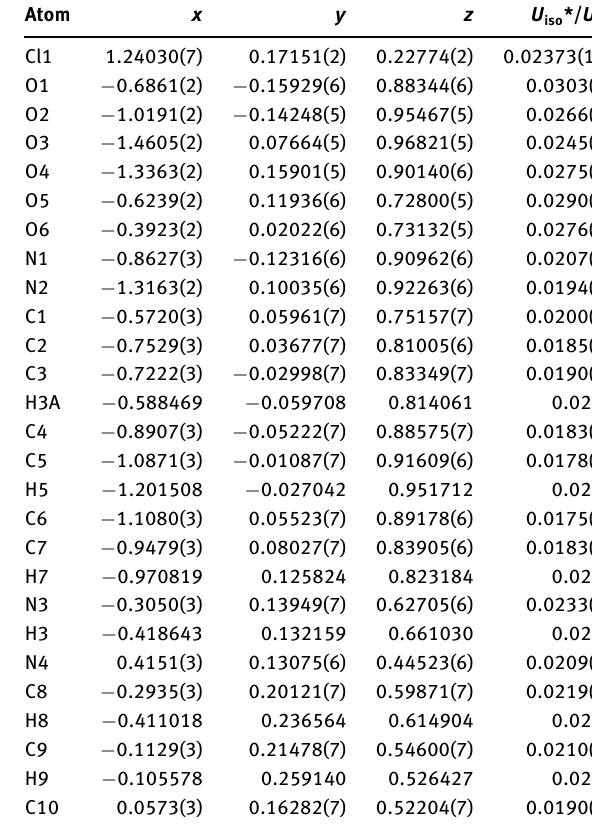
Table 2: Fractional atomic coordinates and isotropic or equivalent isotropic displacement parameters (Å 2